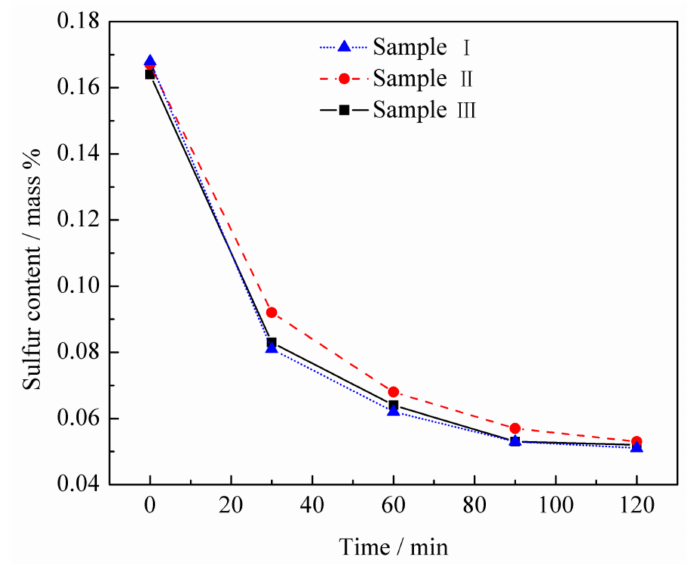
Figure 4. Sulfur content of the samples as a function of reaction time.